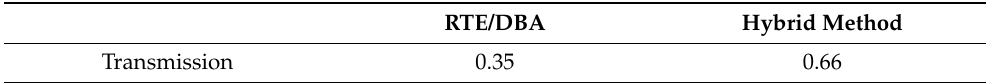
the hybrid method from Figure 6. The table is adapted with permission from Ref. [2]. © 2019 IEEE.